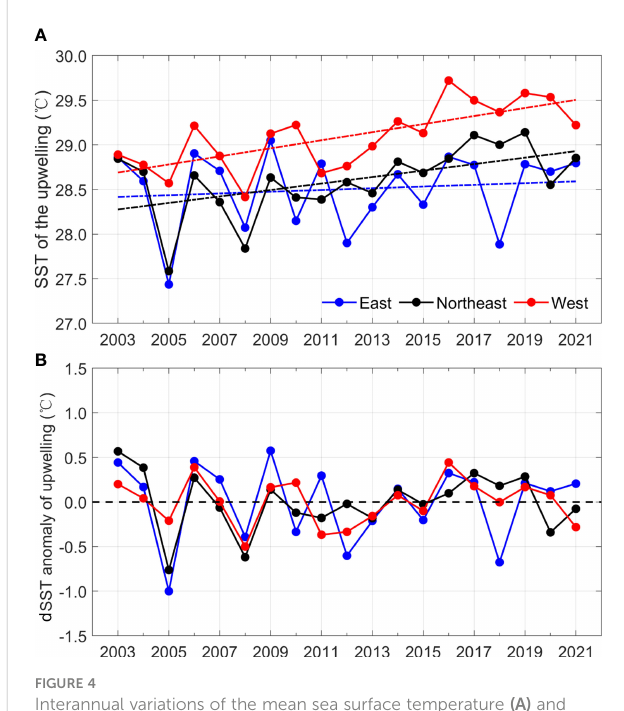
FIGURE 4 Interannual variations of the mean sea surface temperature (A) and detrended sea surface temperature anomaly (B) in east, northeast, and west upwelling regions.